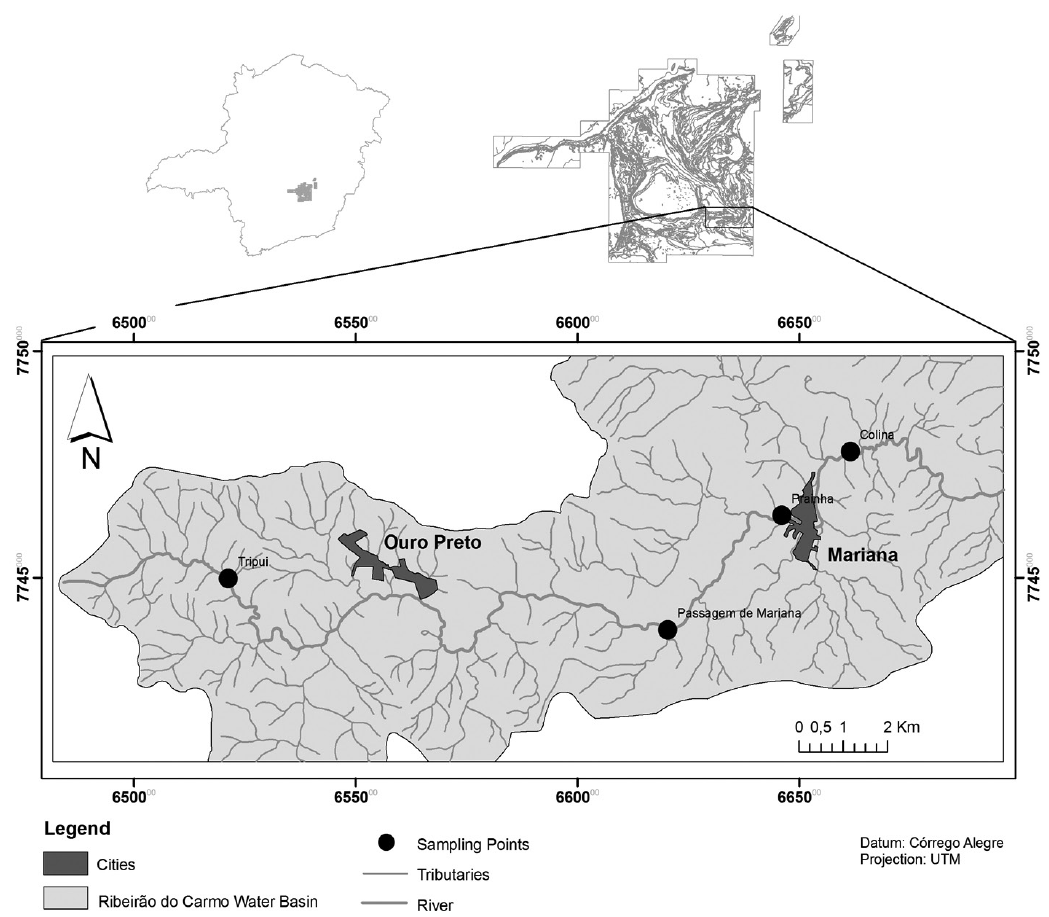
Figure 1. Study area demonstrating the sampling points. Source: modified from IBGE